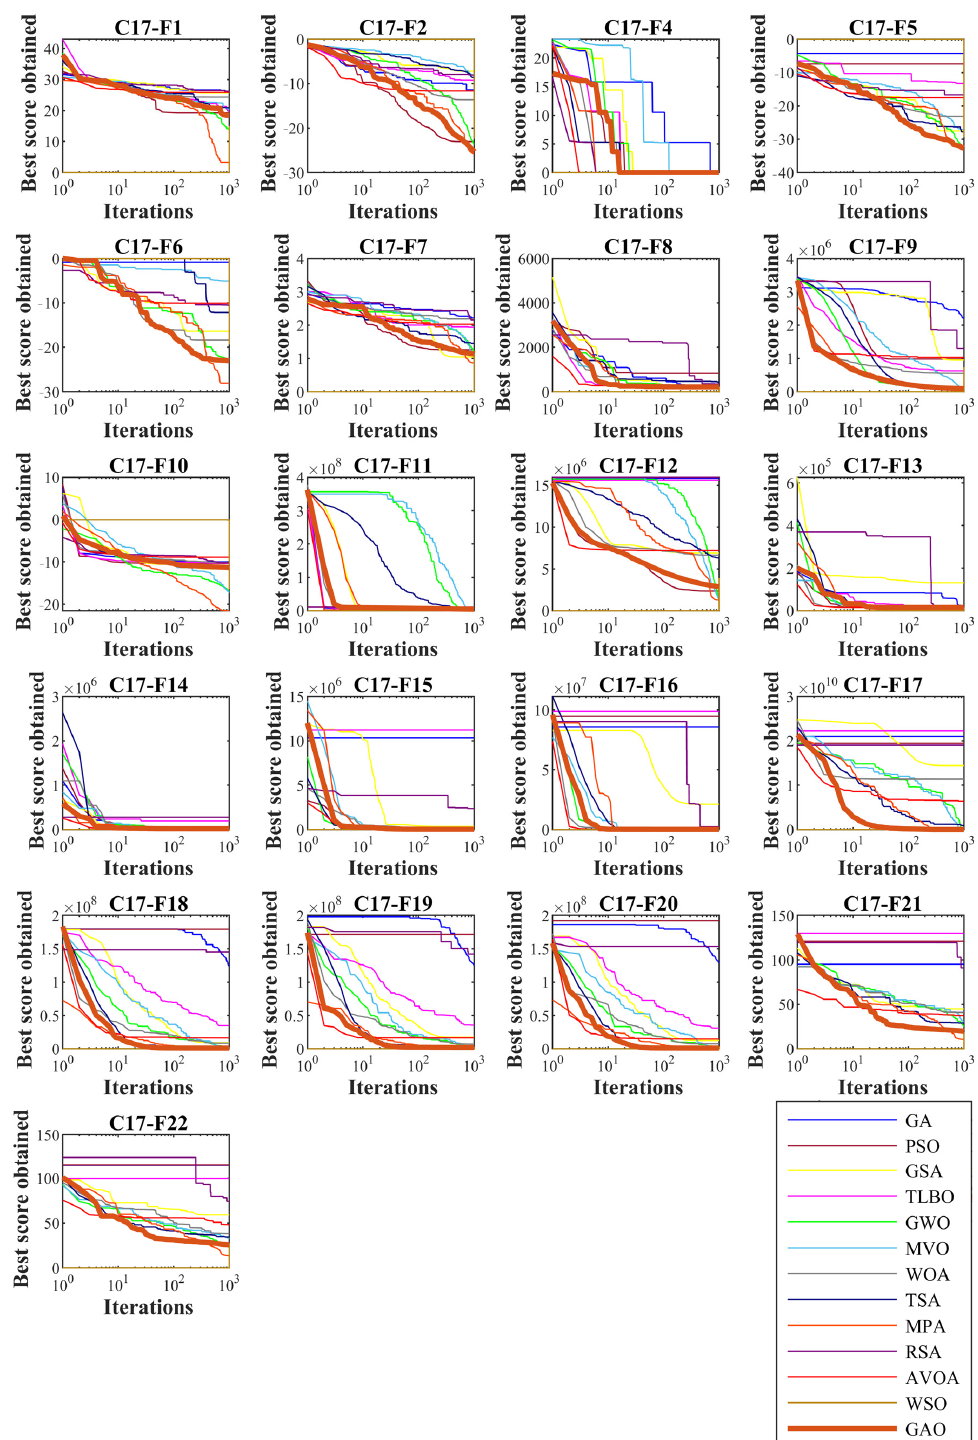
Figure 8. Convergence curves of GAO and competitor algorithms performance on the CEC 2011 test suite.